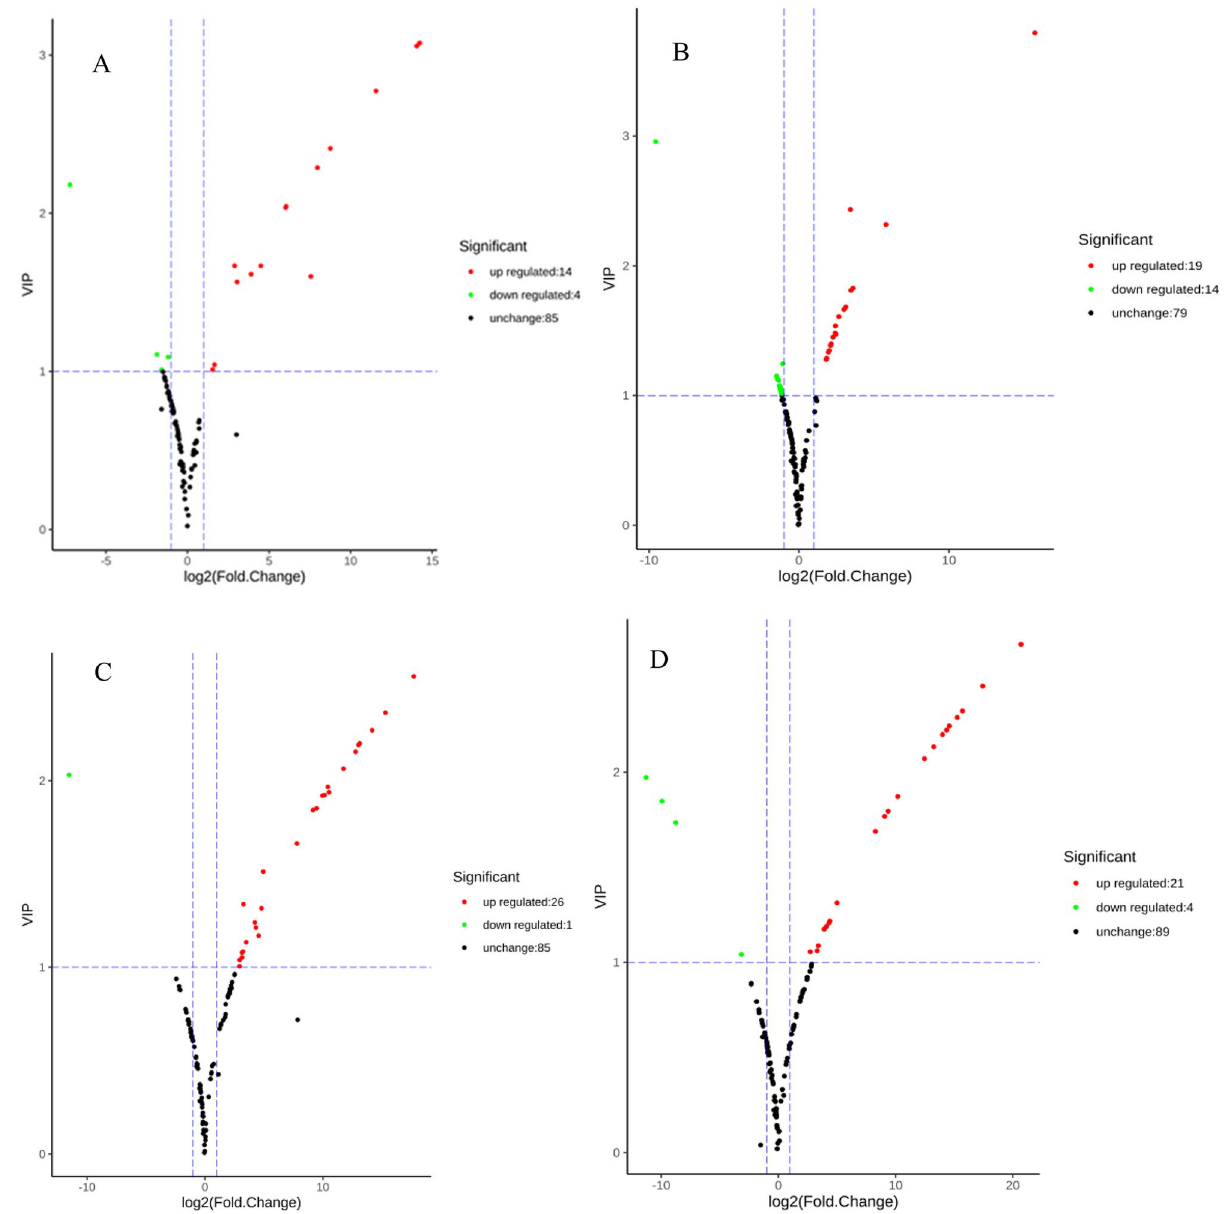
Figure 2. Volcano Map of Differential Metabolites. ( A ): HN52 vs HN71; ( B ): HNS52 vs HNS71; ( C ): HN52 vs HNS52; ( D ): HN71 vs